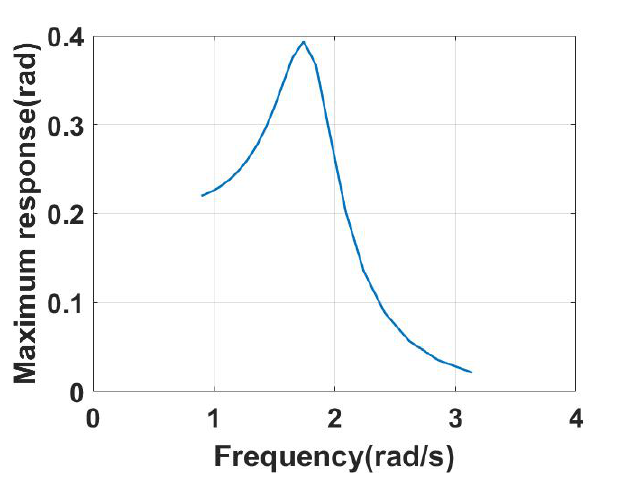
Figure 3. The frequency response of the dynamics of the Wavestar